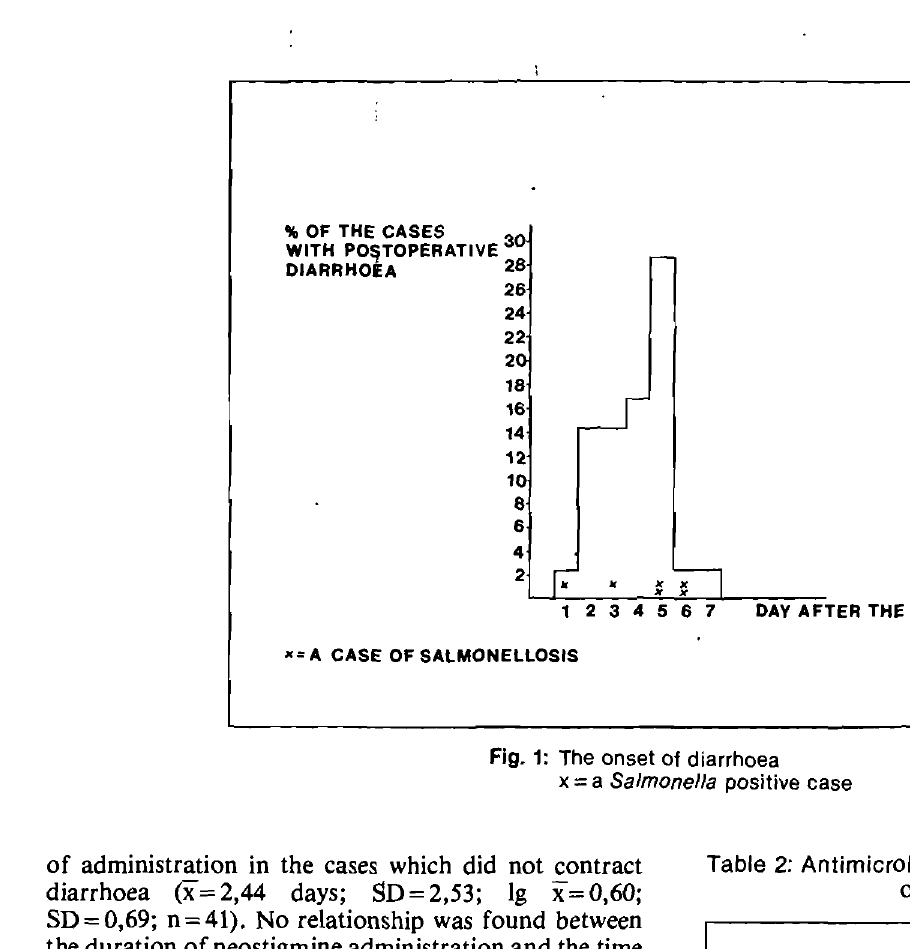
Fig. 1: The onset of diarrhoea = x a Salmonella positive case